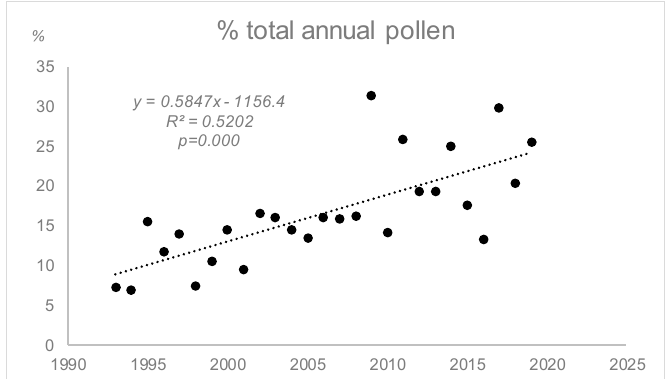
Figure 4. Trend of the percentage of airborne Quercus pollen concentrations from 1993 to 2019 regarding to the total pollen content in the atmosphere.